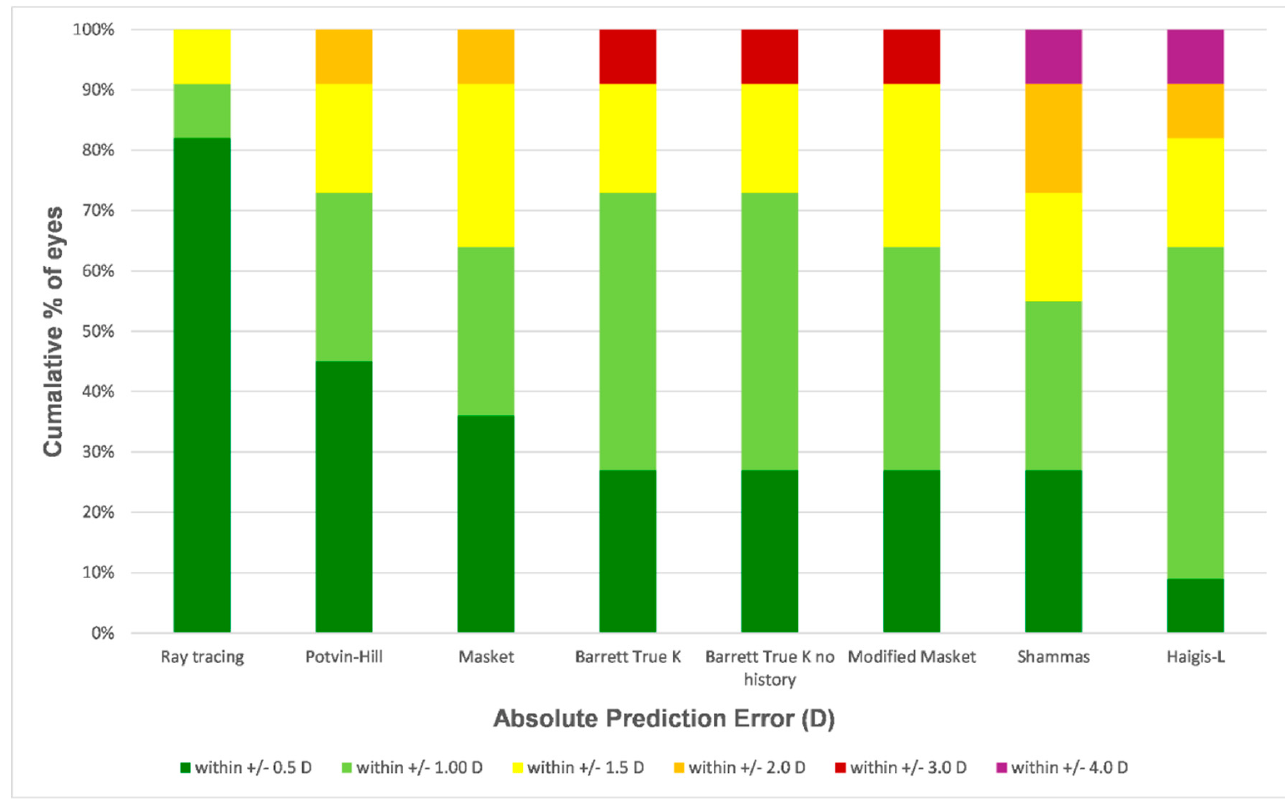
Figure 2. Histogram analysis comparing the percentage of eyes within given prediction error ranges. The formulas were sorted by the proportion of eyes within ±0.50D in descending order.